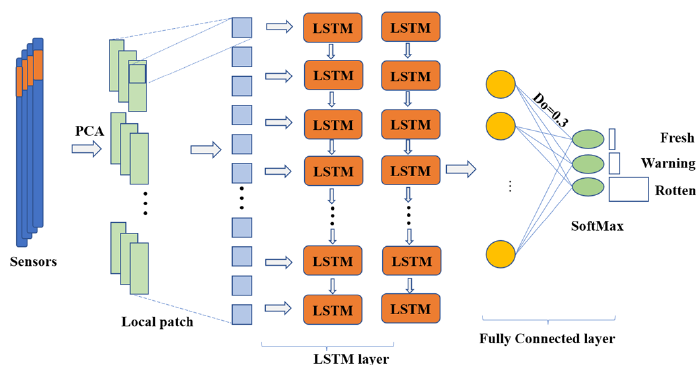
Figure 16. Structure of the LSTM model.